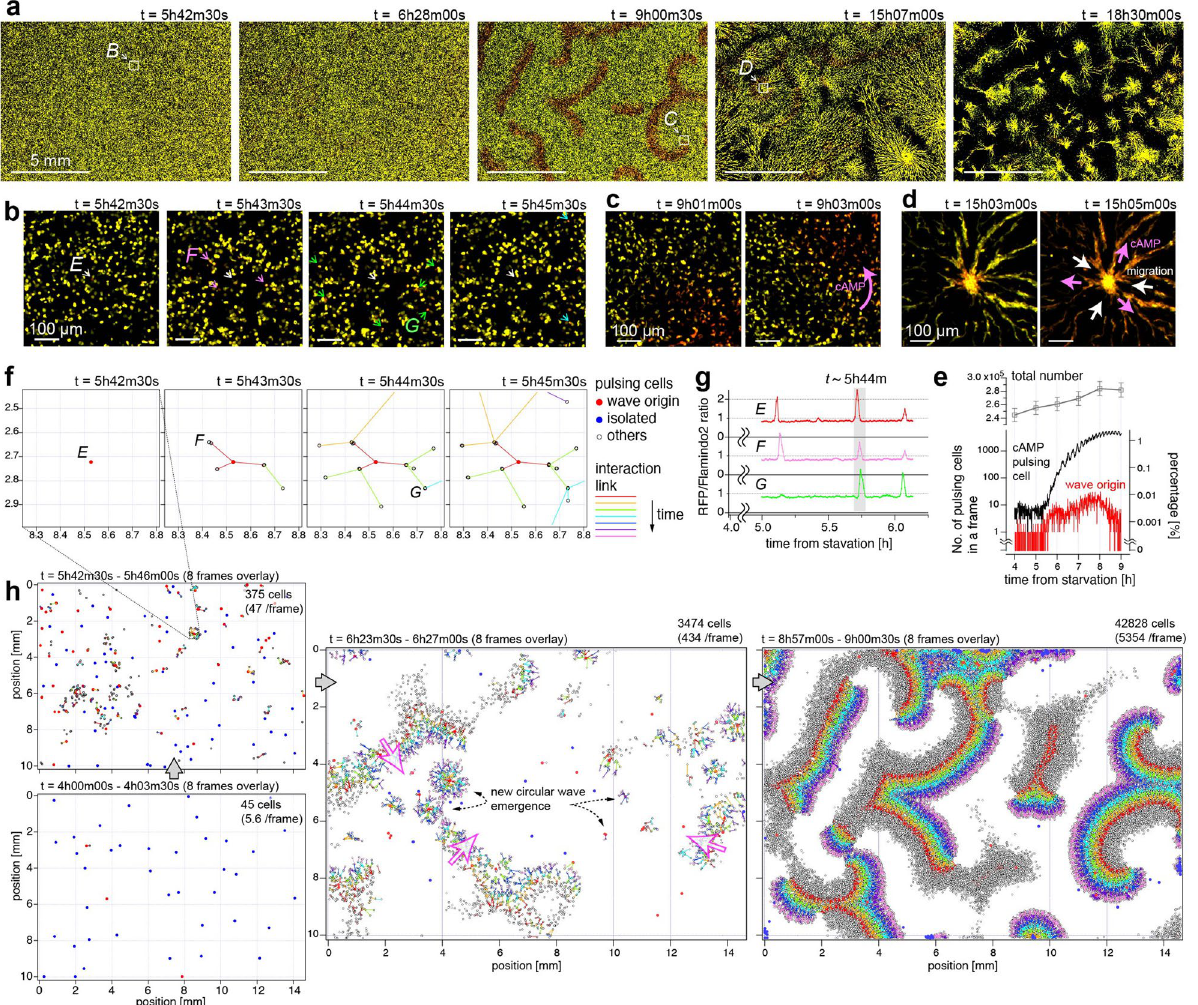
Figure 5. Rare-cell-triggered macroscale pattern formation of D. discoideum on a centimeter scale. The D. discoideum cells express two fluorescent proteins, namely, Flamindo2 and mRFP, which are sensitive and insensitive to [cAMP], respectively. Images were recorded every 30 s over 16 h after 4 h following cellular starvation ( t = 0h00m). Light power densities of 470 nm and 525 nm were 13.4 mW/cm 2 and 15.4 mW/cm 2 , respectively. ( a ) Evolution of macroscale pattern on a large time scale. The images are shown in 8bit-RGB, in which the green and red colors reflect the intensity of Flamindo2 and mRFP, respectively. The color scales were adjusted so that the cell color changed from yellow to red upon an increase in the [cAMP] from low to high. The time counters indicate the time conceded since the starvation. ( b – d ) Closeups of three locations indicated by dashed squares in ( a ) at the three time-regions; region B at t ~ 5h42m ( b ), C at t ~ 9h01m ( c ) and D at t ~ 15h03m ( d ). ( b ) The central cell, denoted with a white arrow, originated a [cAMP] wave, which propagated to several cells denoted with pink, green, and light-blue arrows. ( c – d ) Propagation of [cAMP] and cell migration are indicated with pink and white arrows, respectively. ( e ) Time evolution of the number of pulsing cells (black), cells working as wave origins (red), all cells (gray). Their percentage in total cells are represented by the right axis. ( f ) Distribution of auto-detected cell positions with tree-network diagram of [cAMP] propagation at the same location and frames as ( b ). ( g ) Temporal profiles of the fluorescence intensity ratio (mRFP/Flamindo2) of the three cells marked with E – G in ( f ). ( h ) Scatter plots of cell positions across 8 successive frames with their tree-network diagram in the full FOV at four